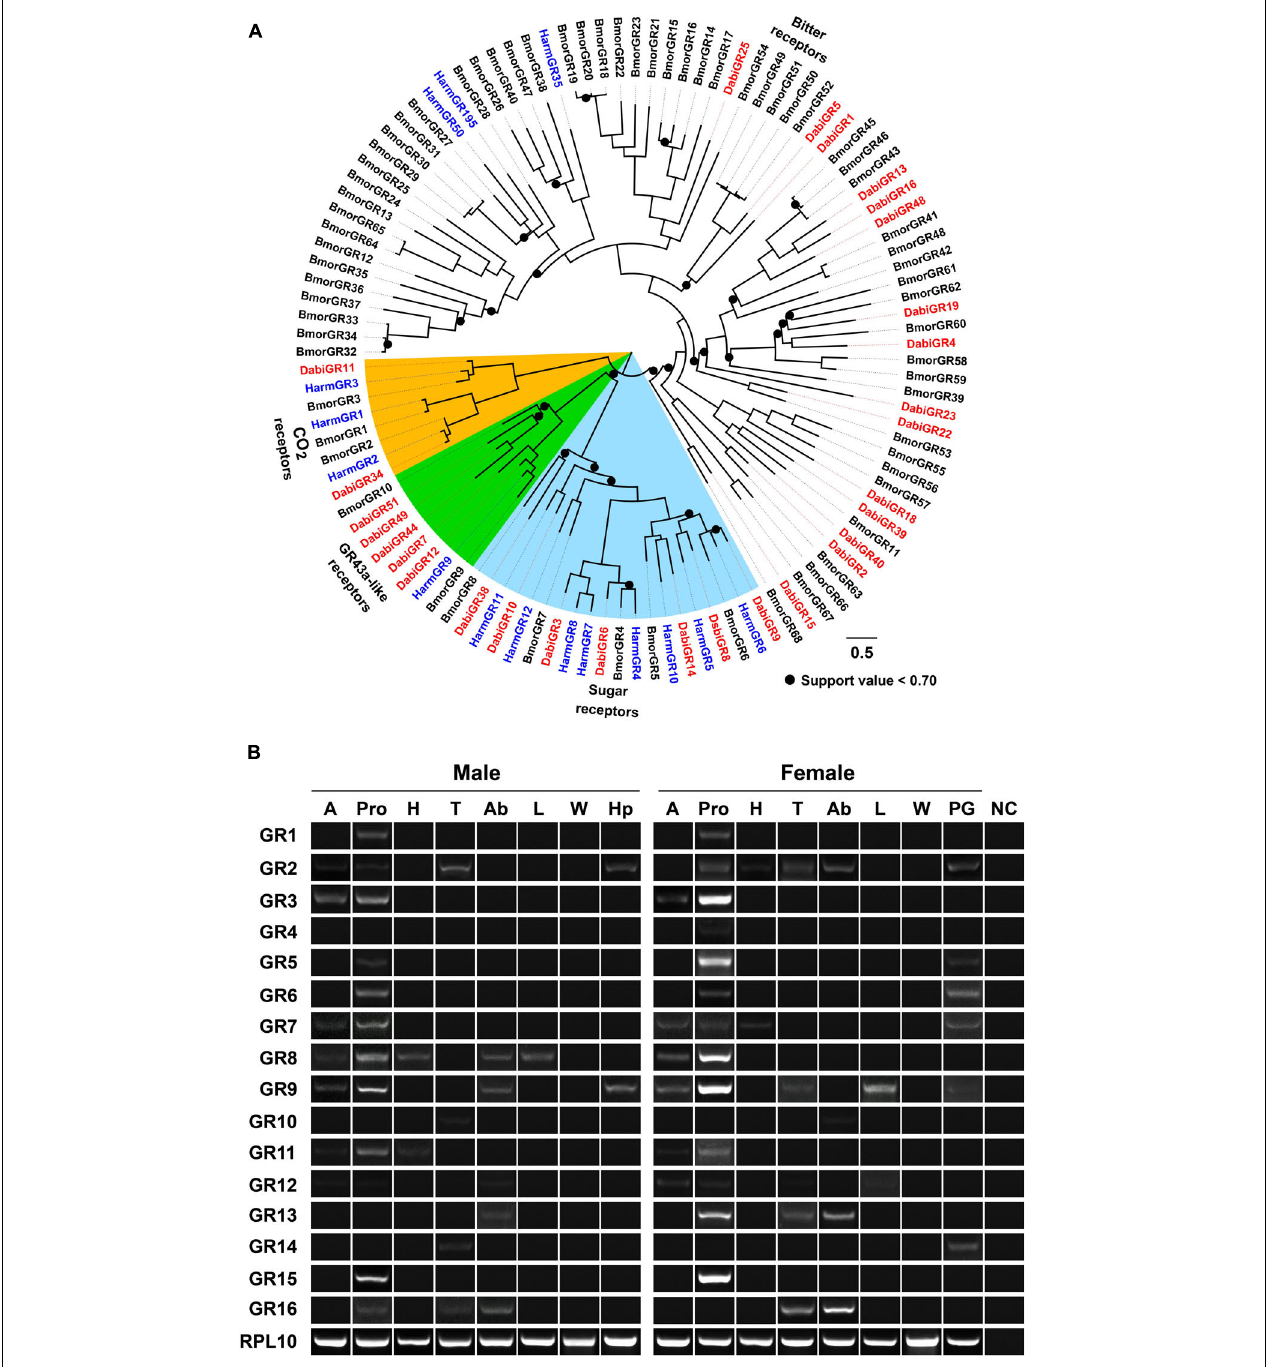
FIGURE 6 | The candidate GR gene family in D. abietella . (A) The phylogeny of GRs in B. mori (Bmor, black), D. abietella (Dabi, red), and H. armigera (Harm, blue). Fifteen HarmGRs were included, representing 3 CO 2 , 1 GR43a–like and 8 sugar GRs, as well as 3 bitter GRs functionally characterized. (B) Expression profiles of candidate DabiGRs in different tissues of both sexes from D. abietella . A reference gene, DabiPRL10 , was used to check the quality and quantity of cDNA templates. NC, negative control using sterile water as the template. The full names of tissues are seen in Table 1 .